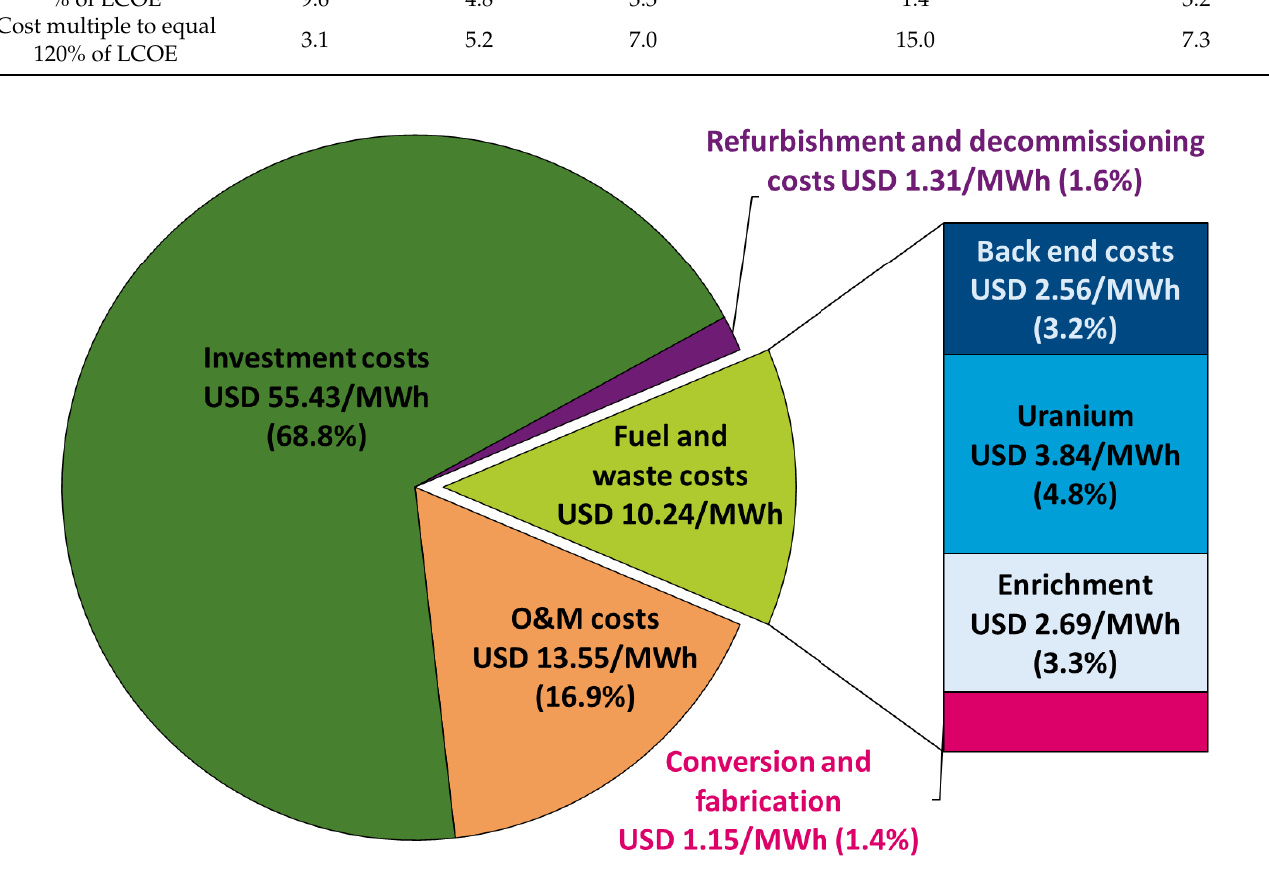
Figure 1. LCOE breakdown across the nuclear fuel cycle